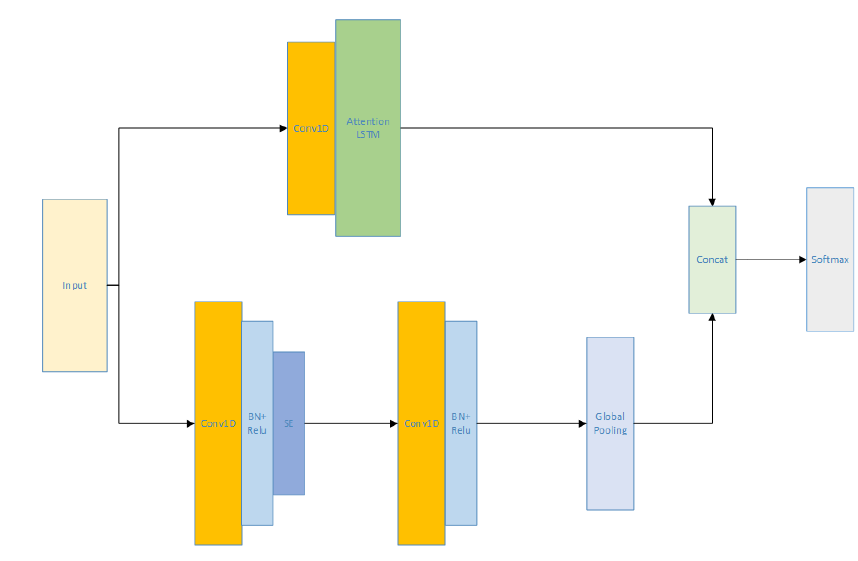
Figure 2. The architecture of the proposed AL-CNN which shows each step of the